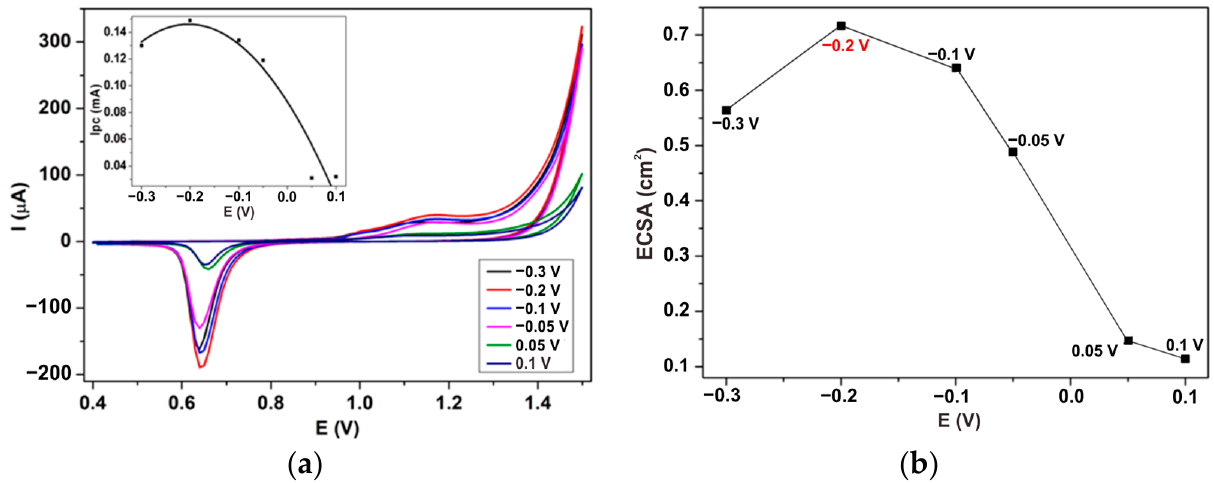
Scheme 1. The gold nano spikes on screen-printed carbon electrodes for dopamine detection incor- porated with oxidation-reduction reaction.